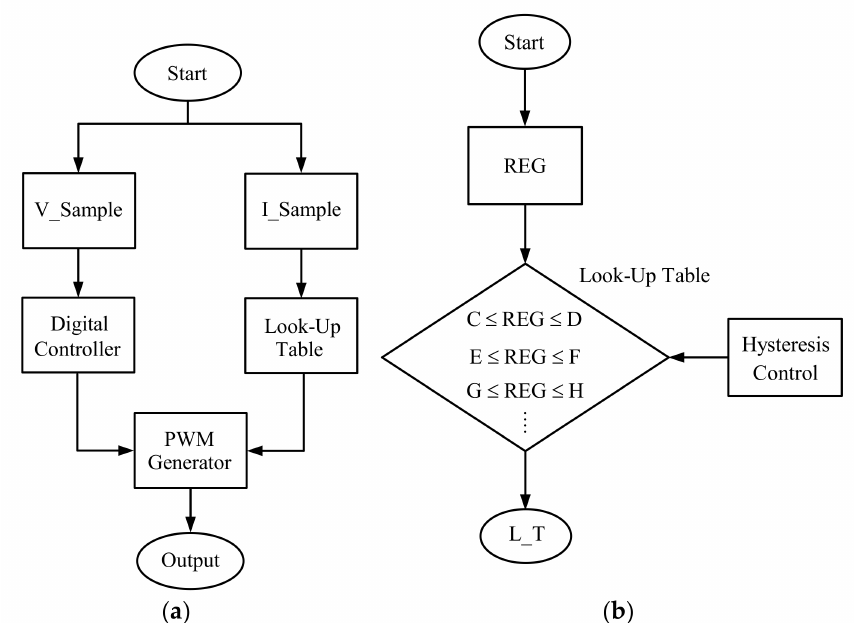
Figure 13. ( a ) System operation flow chart; ( b ) look-up table operation flow chart. PWM, pulse width